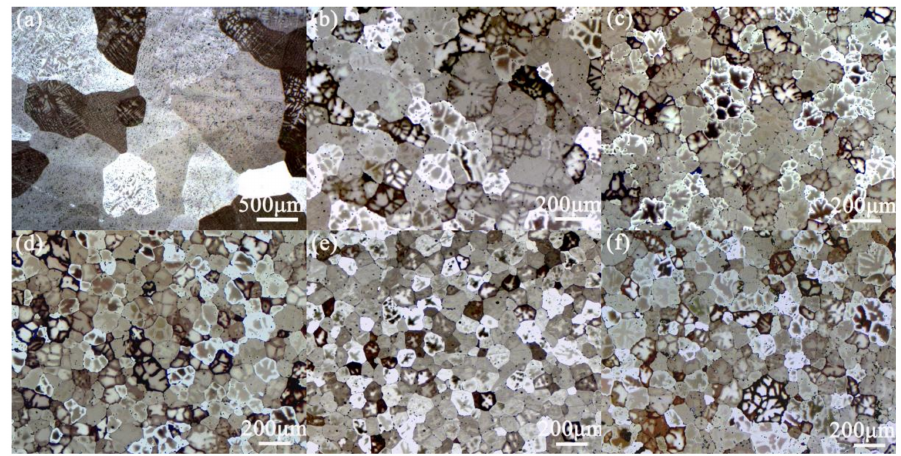
Figure 1. Microstructures of Al-2Cu alloy ( a ) without addition of inoculant and by adding 0.4% Al-5Ti-1B + La addition of ( b ) 0%, ( c ) 0.02%, ( d ) 0.06%, ( e ) 0.08%, and ( f ) 0.10%.